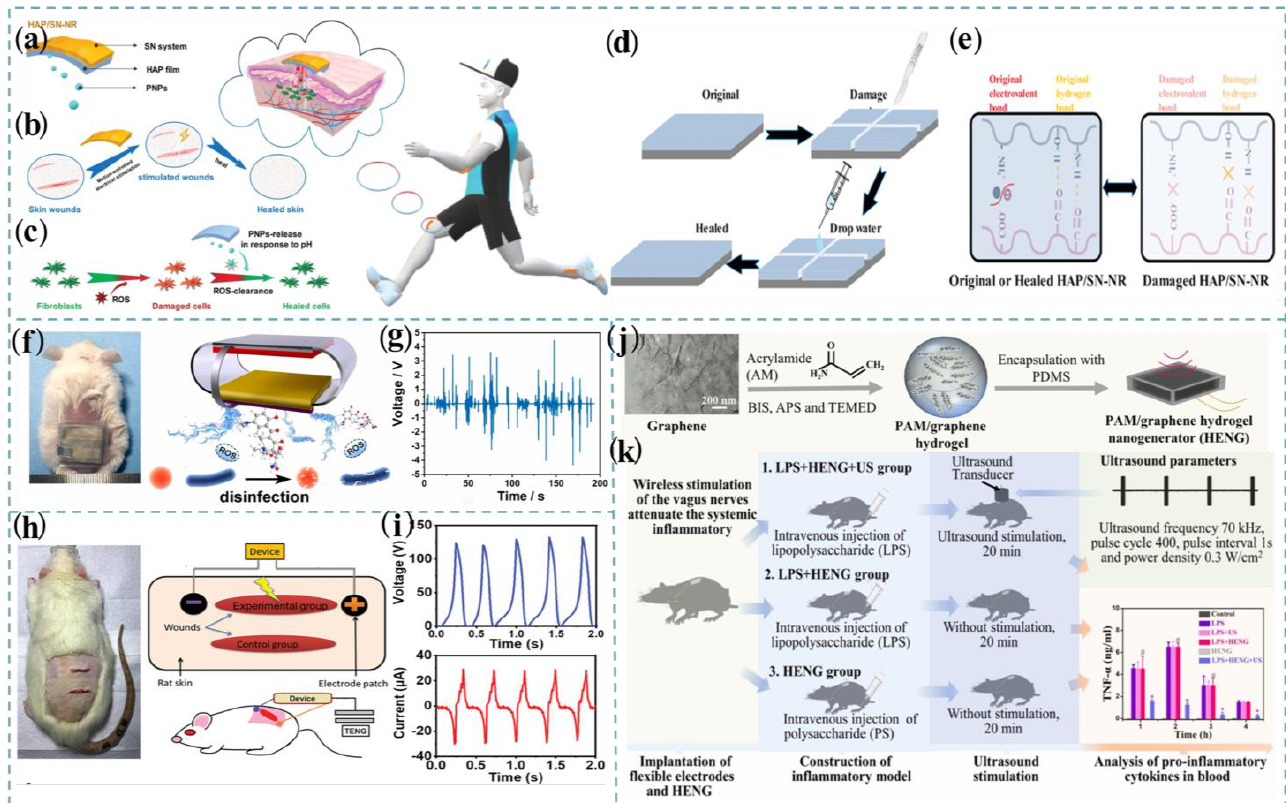
Figure 14. ( a ) HAP/SN-NR comprises utilized film and a self-powered nanogenerator (SN). ( b ) The work process of the SN system under motion-activated electrical stimulation to make skin convalescent. ( c ) The ROS-clearance of HAP film with ROS and pH dual response to rehabilitate damaged human dermal fibroblasts. ( d ) The diagrammatic sketch of the self-healing process. ( e ) The self-healing mechanism of HAP film [122]. Copyright 2021, WILEY-VCH VERLAG GMBH. ( f ) Photograph of the mouse wearing the MSETENG patch on infected wounds in the back and the proposed mechanism for promoting infected wound healing. ( g ) Output voltages of the MSETENG patch induced by the mouse’s motion [68]. Copyright 2021, ELSEVIER. ( h ) A schematic system set up by B-TENG to induce ES for bruise therapy. ( i ) The condition of output voltage and current of B-TENG for ES [123]. Copyright 2022, WILEY. ( j ) The fabrication processes of HENG. ( k ) Schematic representation of experimental protocols of the ultrasound-driven electrical stimulation of vagus nerves for attenuating the endotoxin-induced systemic inflammation [124]. Copyright 2021, ELSEVIER.